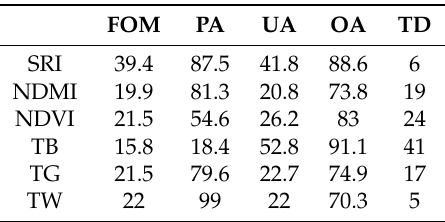
Table 1. Figure Of Merit (FOM, %), Producer’s Accuracy (PA, %), User’s Accuracy (UA, %), Overall Accuracy (OA, %) and Temporal Delay (TD, observation) at the Bolivian site. A mean model is used in the MEFP for the method introduced here (SRI), and a first-order harmonic model is used for the other indices. FOM PA UA OA TD